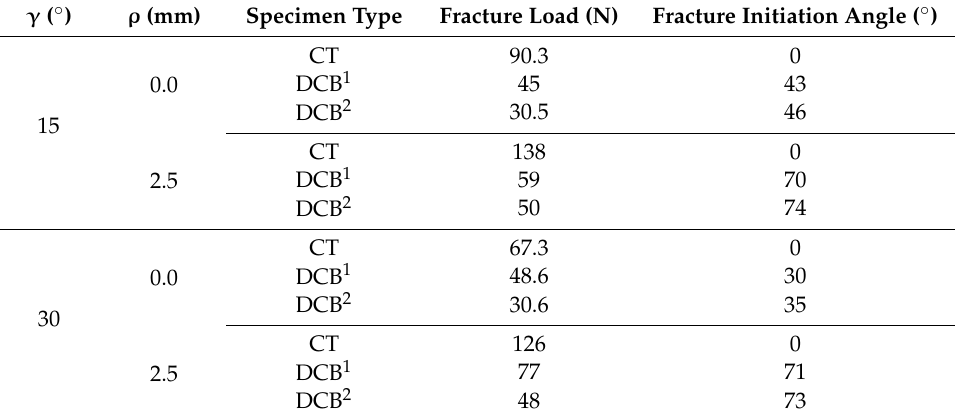
Table 6. A comparison between the test results obtained from sharp V notched specimens ( ρ = 0.0 mm) [17] and VO-notched specimens ( ρ = 2.5 mm). γ ( ◦ ) ρ